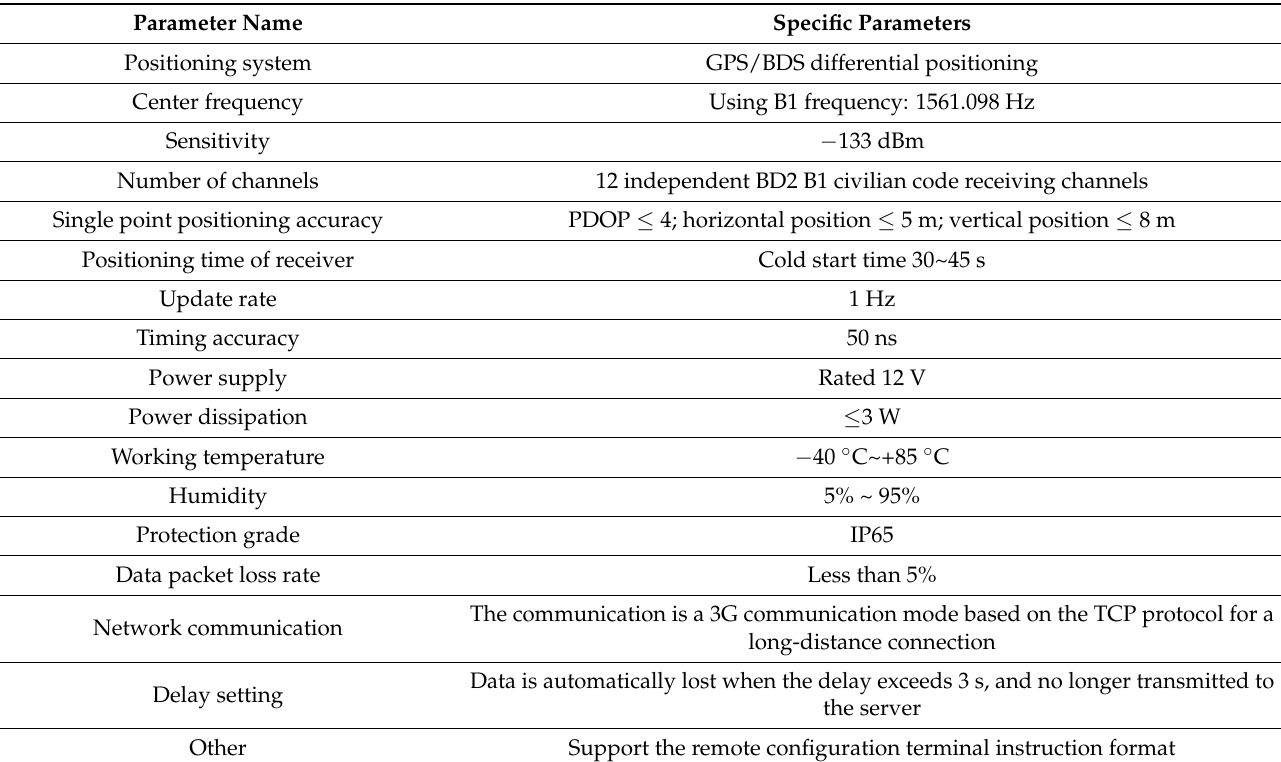
Table 1. Parameters and definition of the bus vehicle